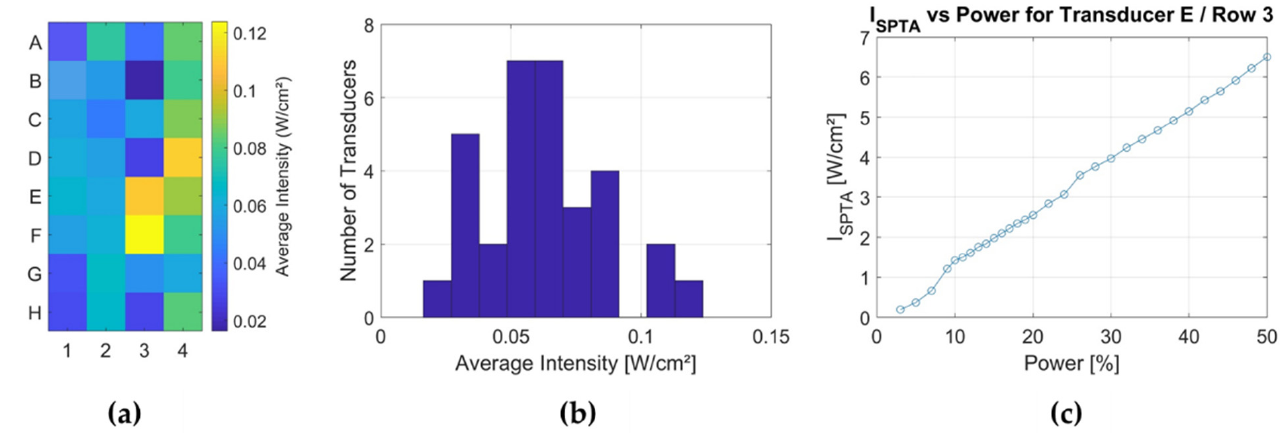
Figure 3. Assessment of the applicator performance. An XY sound field scan was performed in front of the cell applicator. For ( a ), the acoustic intensity I SPTA was averaged over the surface of one well of the 96-well plate in front of each transducer element. ( b ) A histogram allowing assessing the homogeneity of the intensity output. ( a , b ) were performed with a power setting of 1% and were made to compare the relative performance of the different wells, not the absolute intensities. ( c ) The I SPTA as a function of the power setting that can be user-defined using the “Cell Therapy Planning Tool”.